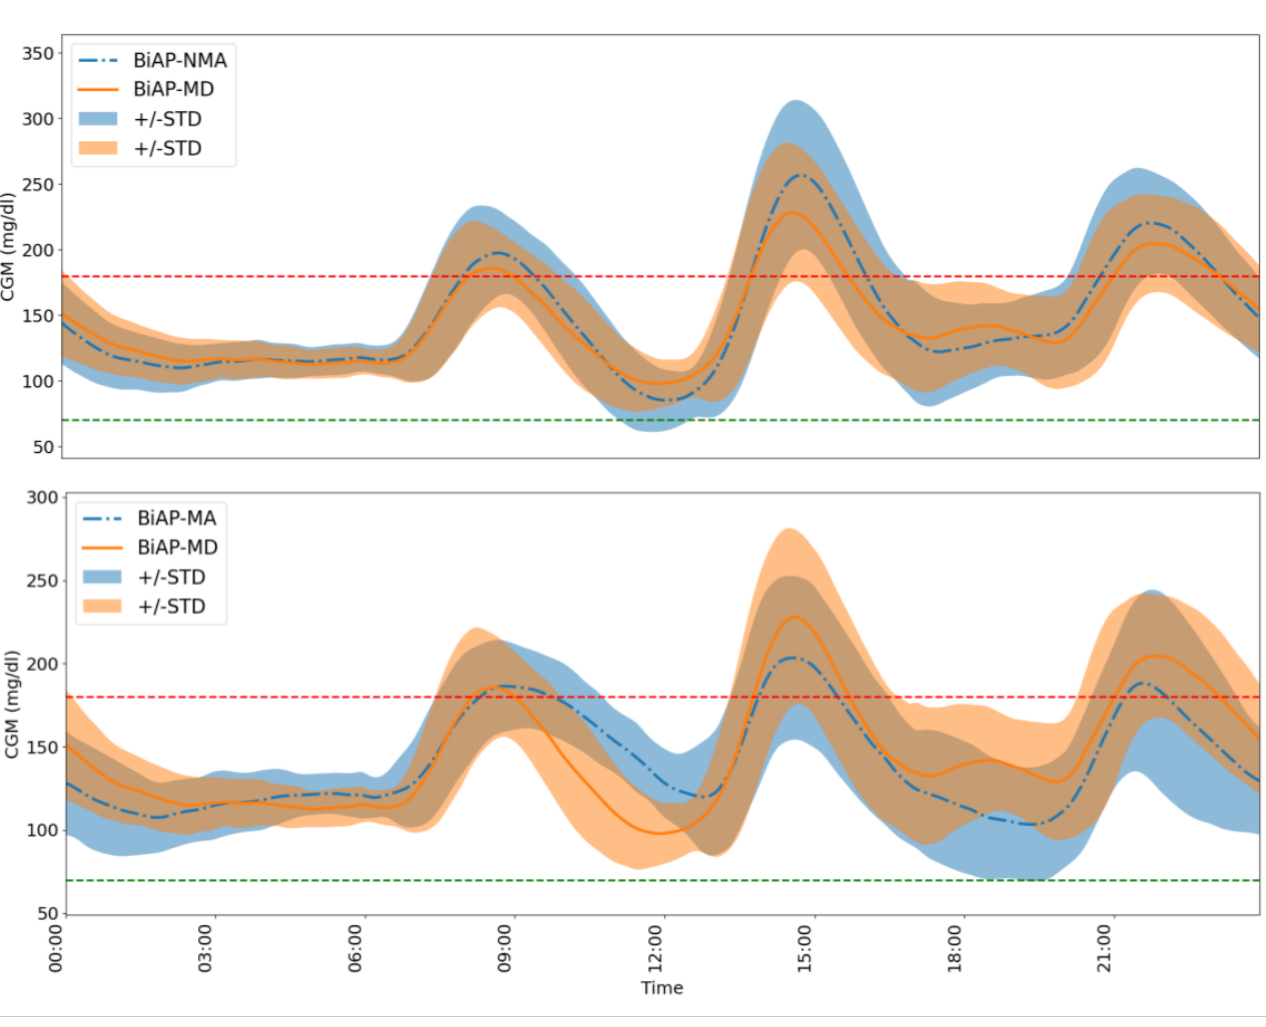
Figure 5. A comparison of the 24 h glucose profile of Adult 3 from the virtual cohort over the 2-month period between the BiAP controller with meal detection and the two baseline configurations. The red and green lines mark the hyperglycaemia and hypoglycaemia threshold, respectively. ( Top ) BiAP-NMA vs. BiAP-MD:A comparison between the BiAP controller performance without and with the meal detection and estimation incorporated. ( Bottom ) BiAP-MA vs. BiAP-MD: A